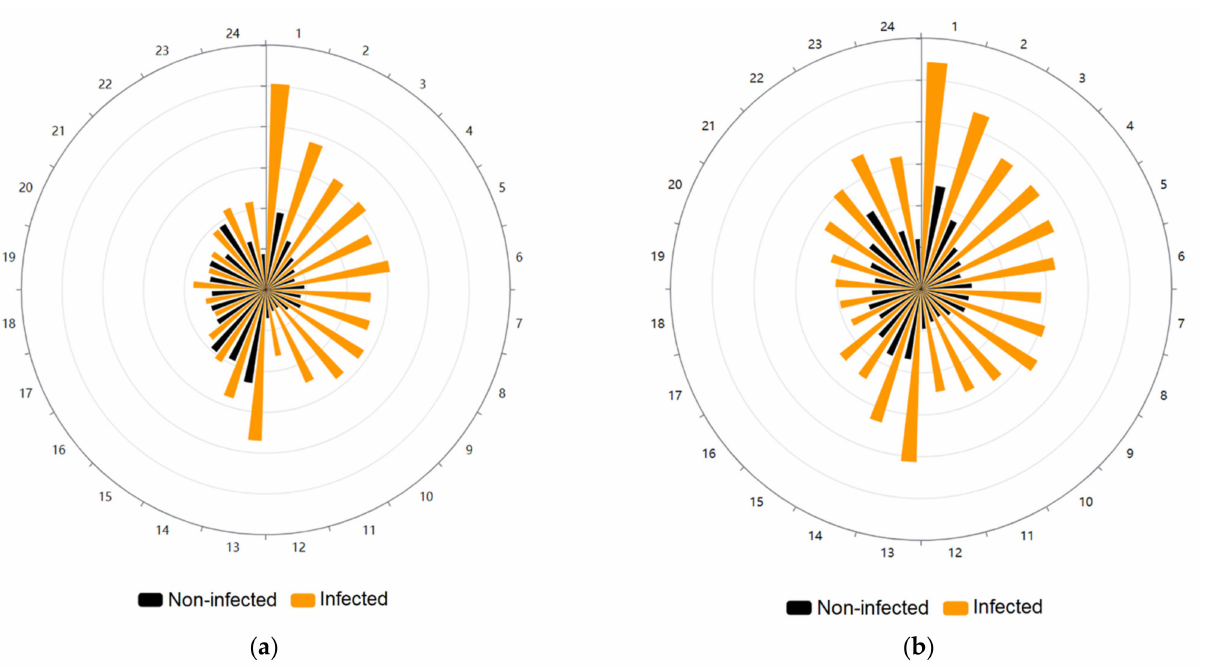
Figure 2. Circular plots showing the locomotor activity per hour of Triatoma infestans . The photophase spans from the first to 12 h, and the scotophase from 13 to 24 h. ( a ) Movement events per hour of T. infestans . The radius is divided into six equal parts, each of 3000 units (movement events). Orange- colored bars show the sum of movement events of the Trypanosoma cruzi -infected individuals and black-colored bars show the non-infected specimens. ( b ) Distance traveled per hour by T. infestans . The radius is divided into six equal parts, each of 5000 units (centimeters). Orange-colored bars show the sum of the distance traveled in centimeters of T. cruzi -infected individuals and black-colored bars show the non-infected